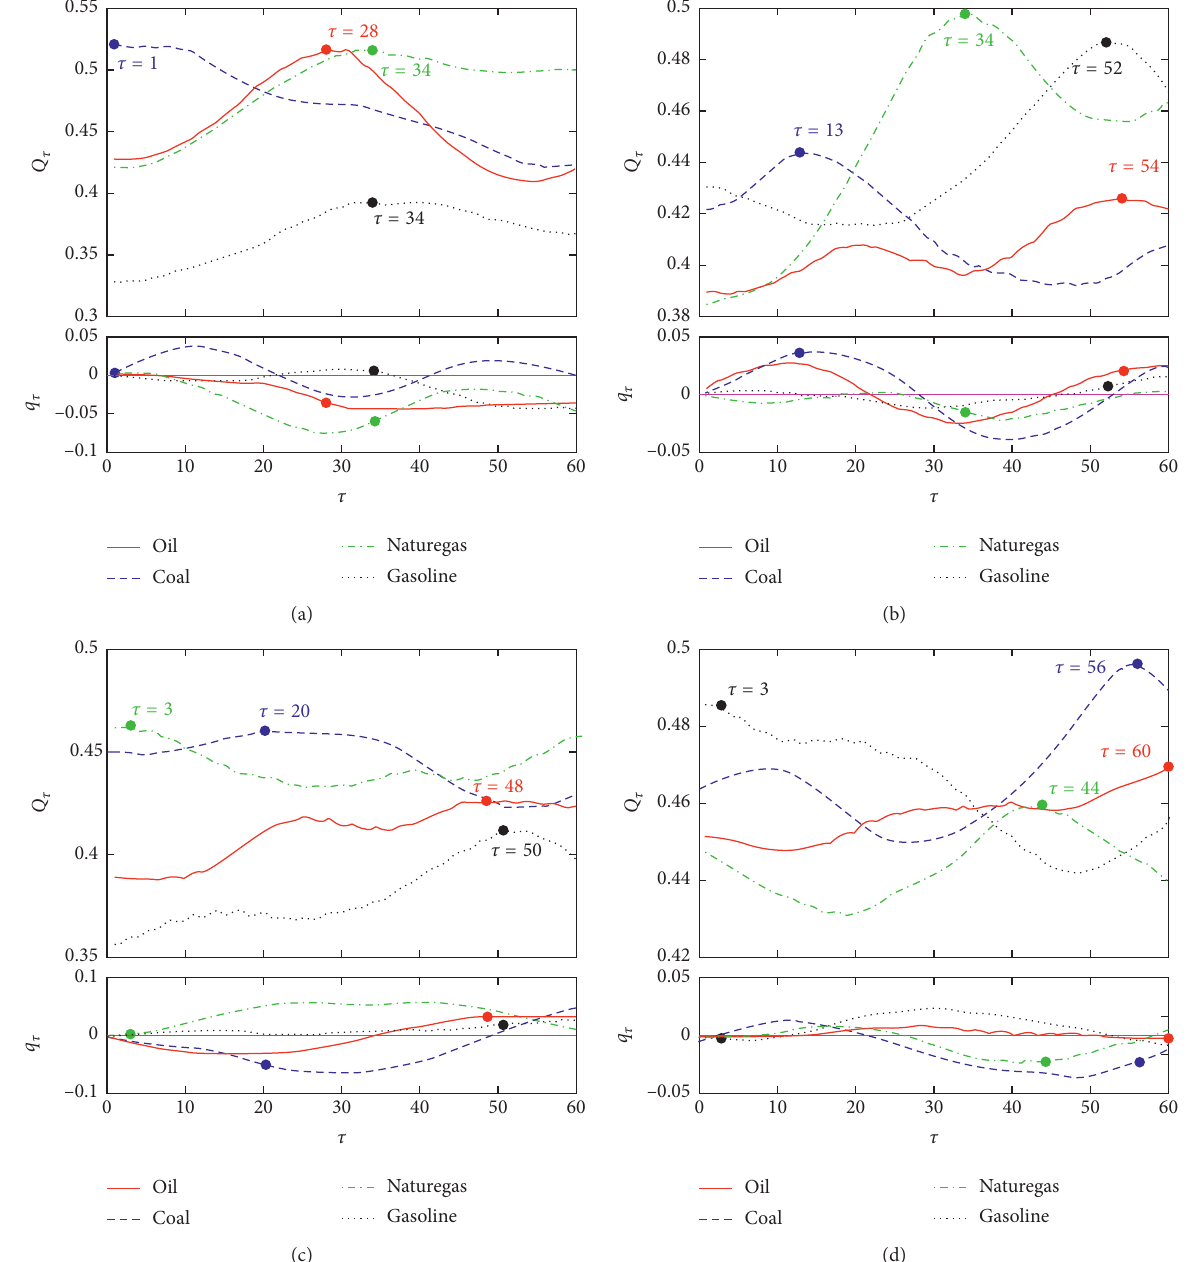
Figure 7: Mutual leading relationship between carbon and energy prices: (a) second stage, (b) transition from second to the third stage, (c) initial stage of the third stage, and (d) current